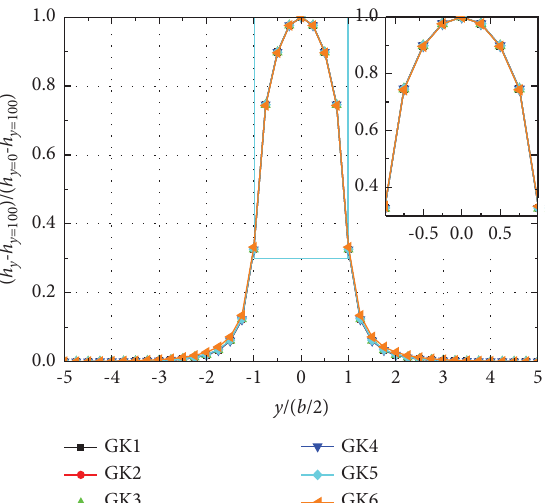
Figure 15: Lateral distribution of the WLDR at the side of the structure in two-layer soil ( b � 40m, l � 10m, d � 30 m).